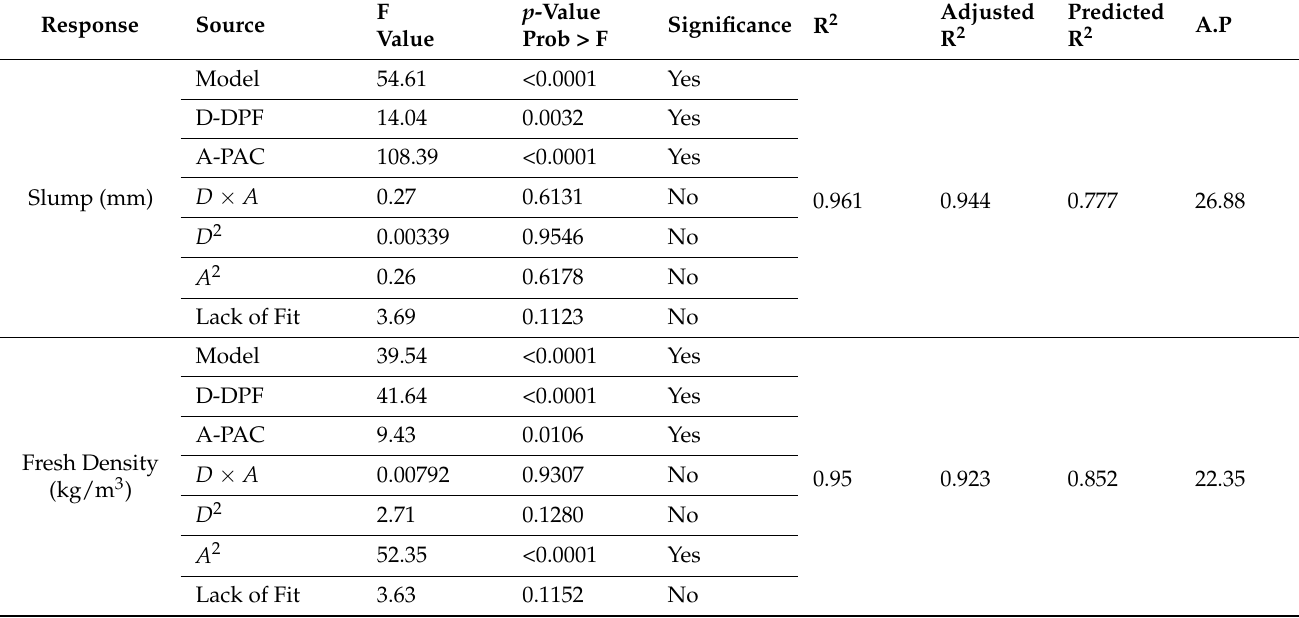
Table 5. Slump and fresh density models’